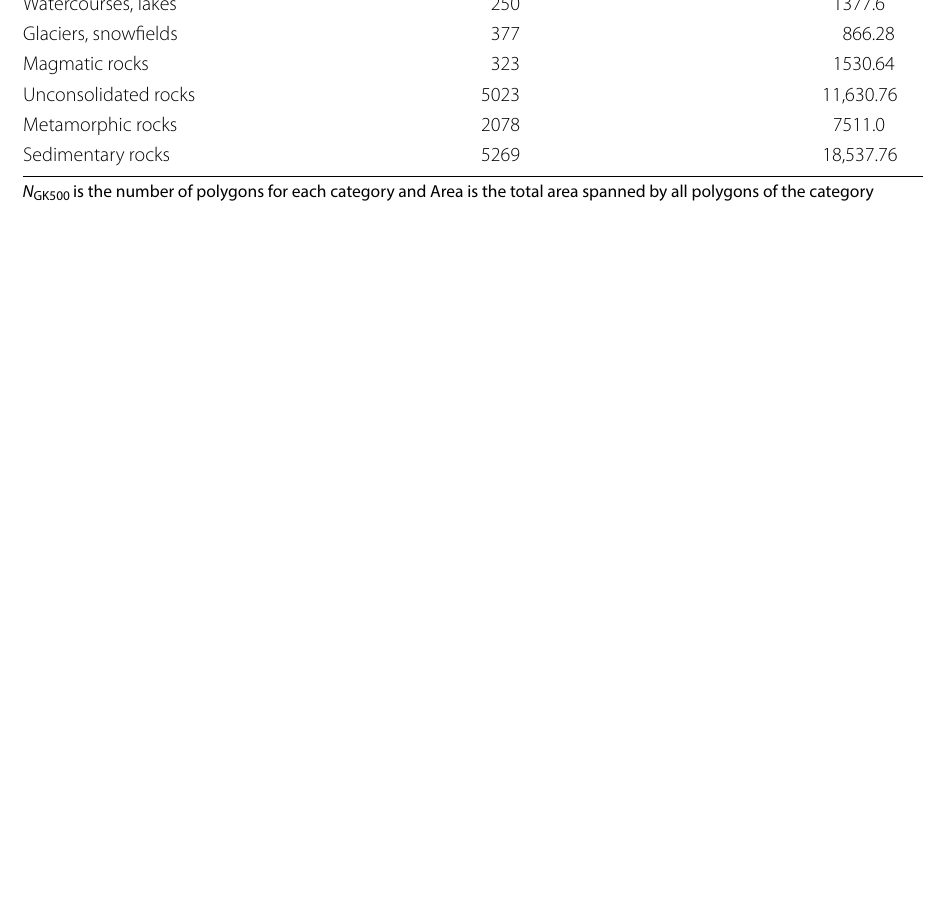
N GK500 is the number of polygons for each category and Area is the total area spanned by all polygons of the category Table 7 Rock formation types [TYPE ROCHE] categories in GK500 dataset